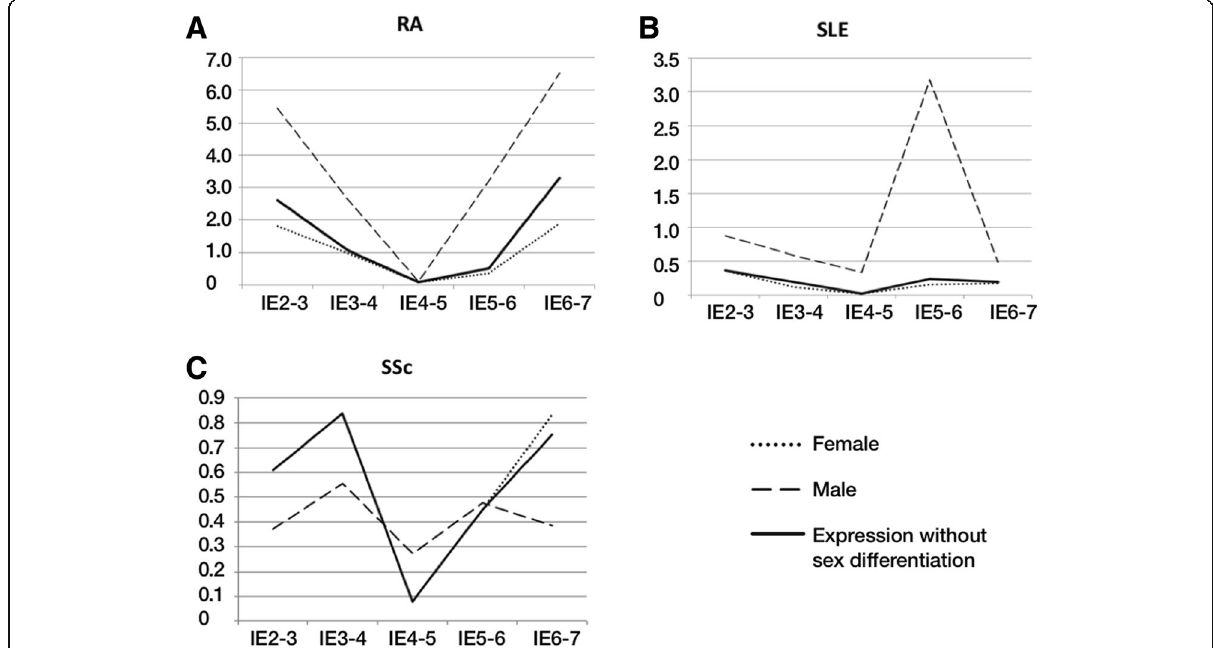
Fig. 5 Expression levels of Ikaros interexonic regions according to sex. Interexon expression in patients with rheumatoid arthritis ( a ), systemic lupus erythaematosus ( b ), and systemic sclerosis ( c ). The solid line shows the expression level without sex differentiation. F, female; M, male; RA, rheumatoid arthritis; SSc, systemic sclerosis; SLE, systemic lupus